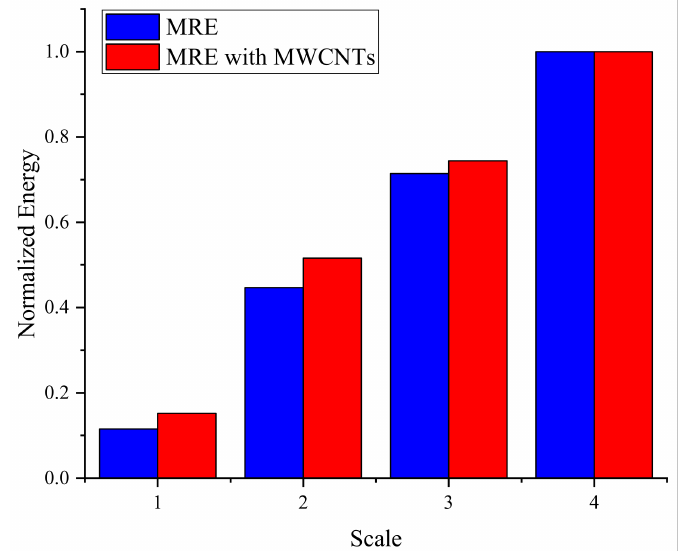
Figure 9. Normalized Energy